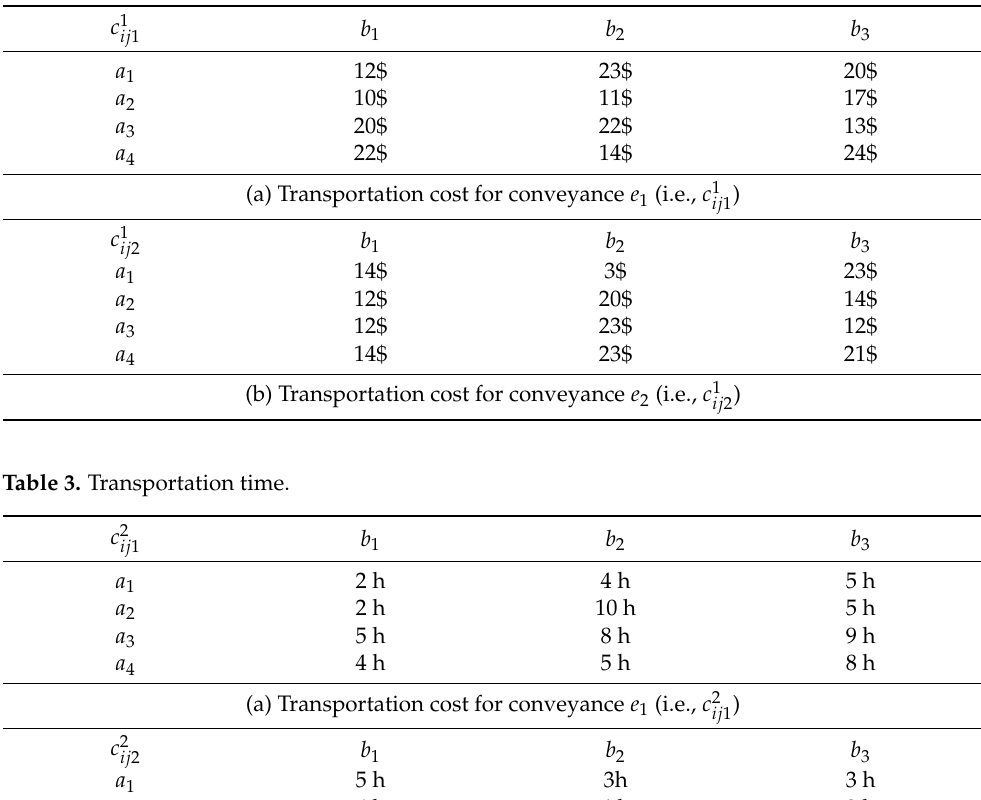
Table 2. Transportation cost.